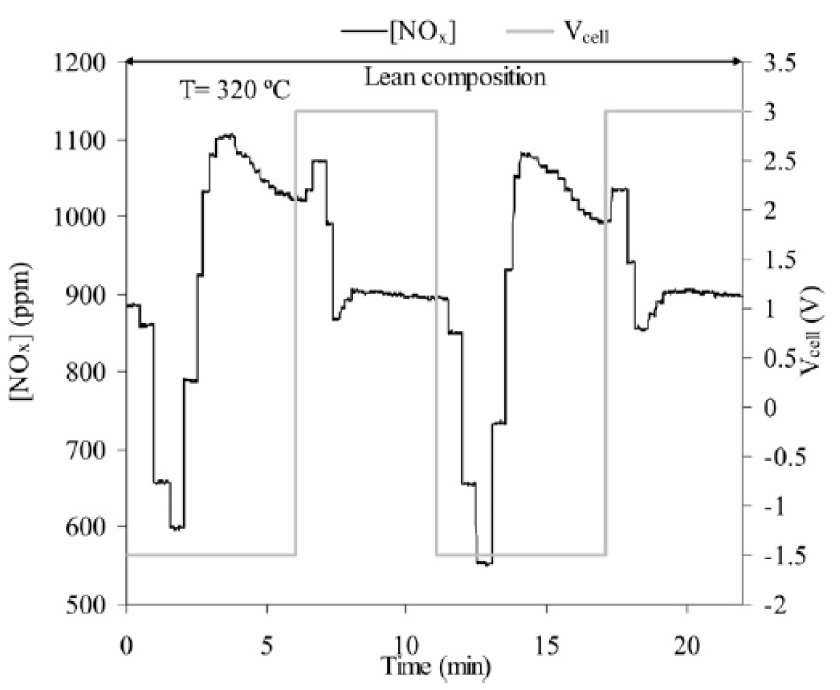
Figure 3. NO x outlet concentration profile vs. time during NO x storage / reduction experiments with a Pt / K + - β ”Al 2 O 3 electrochemical catalyst under a fixed lean reaction composition (NO / C 3 H 6 / O 2 : 1100 ppm / 1000 ppm / 5%, He balance) at 320 ◦ C. NO x storage step: − 1.5 V, NO x reduction step: + 3 V. Reprinted with permission from